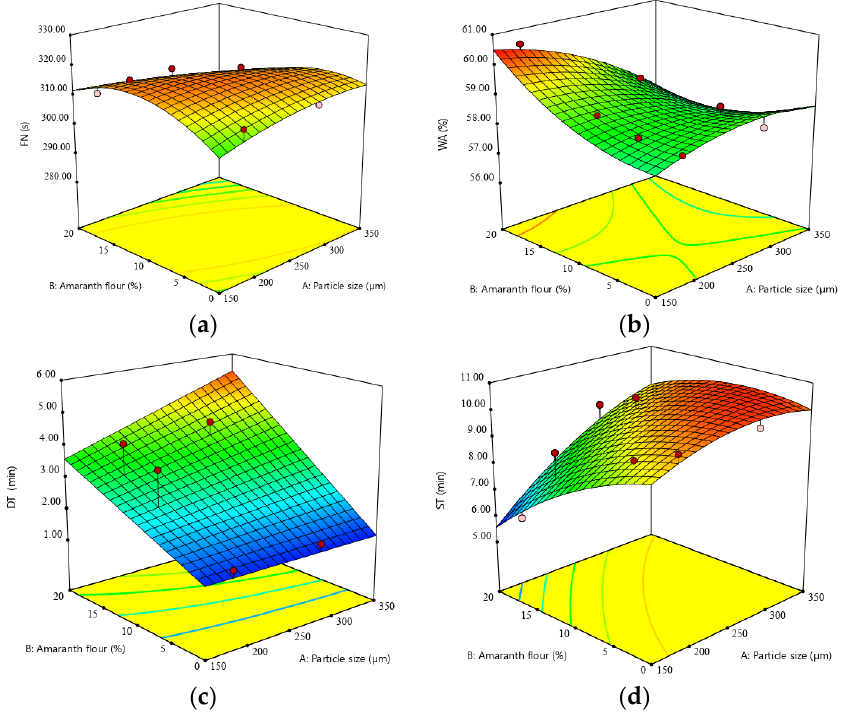
Figure 1. Three-dimensional response surface plots showing the interaction between amaranth flour particle size and addition level on ( a ) the Falling Number index (FN), ( b ) water absorption (WA), ( c ) development time (DT), and the ( d ) dough stability (ST) achieved during mixing. During mixing, the dough was influenced by PS and AF addition to wheat flour.